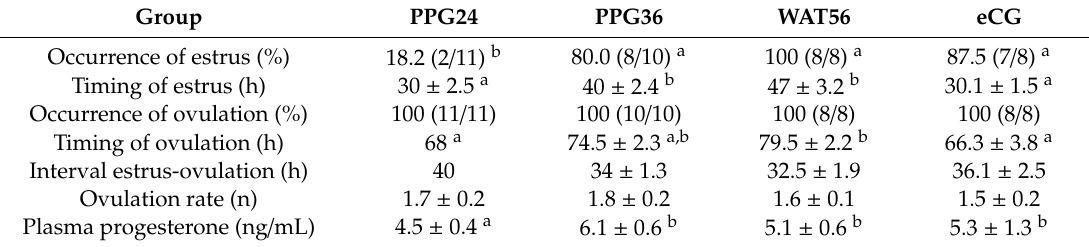
Table 2. Percentage, timing of occurrence and intervals of estrus behavior and ovulation, number of ovulations, and plasma progesterone concentrations in ewes treated with CIDR with PGF 2 α and 400 IU of eCG (at CIDR removal; eCG) or 50 µ g of GnRH in either i.m. distilled water (56 h after CIDR removal; WAT56) or s.c. propylene-glycol (24 or 36 h after CIDR removal; PPG24 and PPG36).